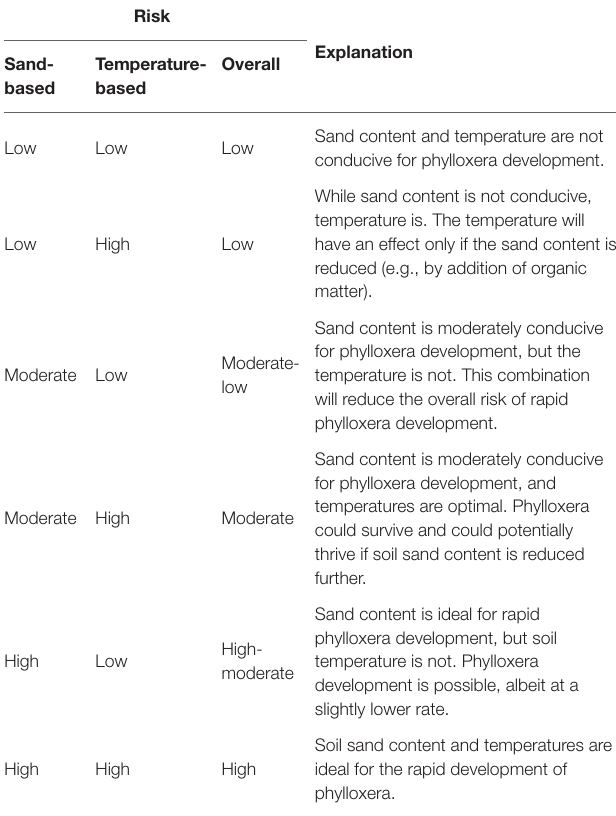
TABLE 2 | Phylloxera risk considering combined effects of soil sand content and soil temperature, and the explanation of risk assessment for the event of phylloxera introduction to a